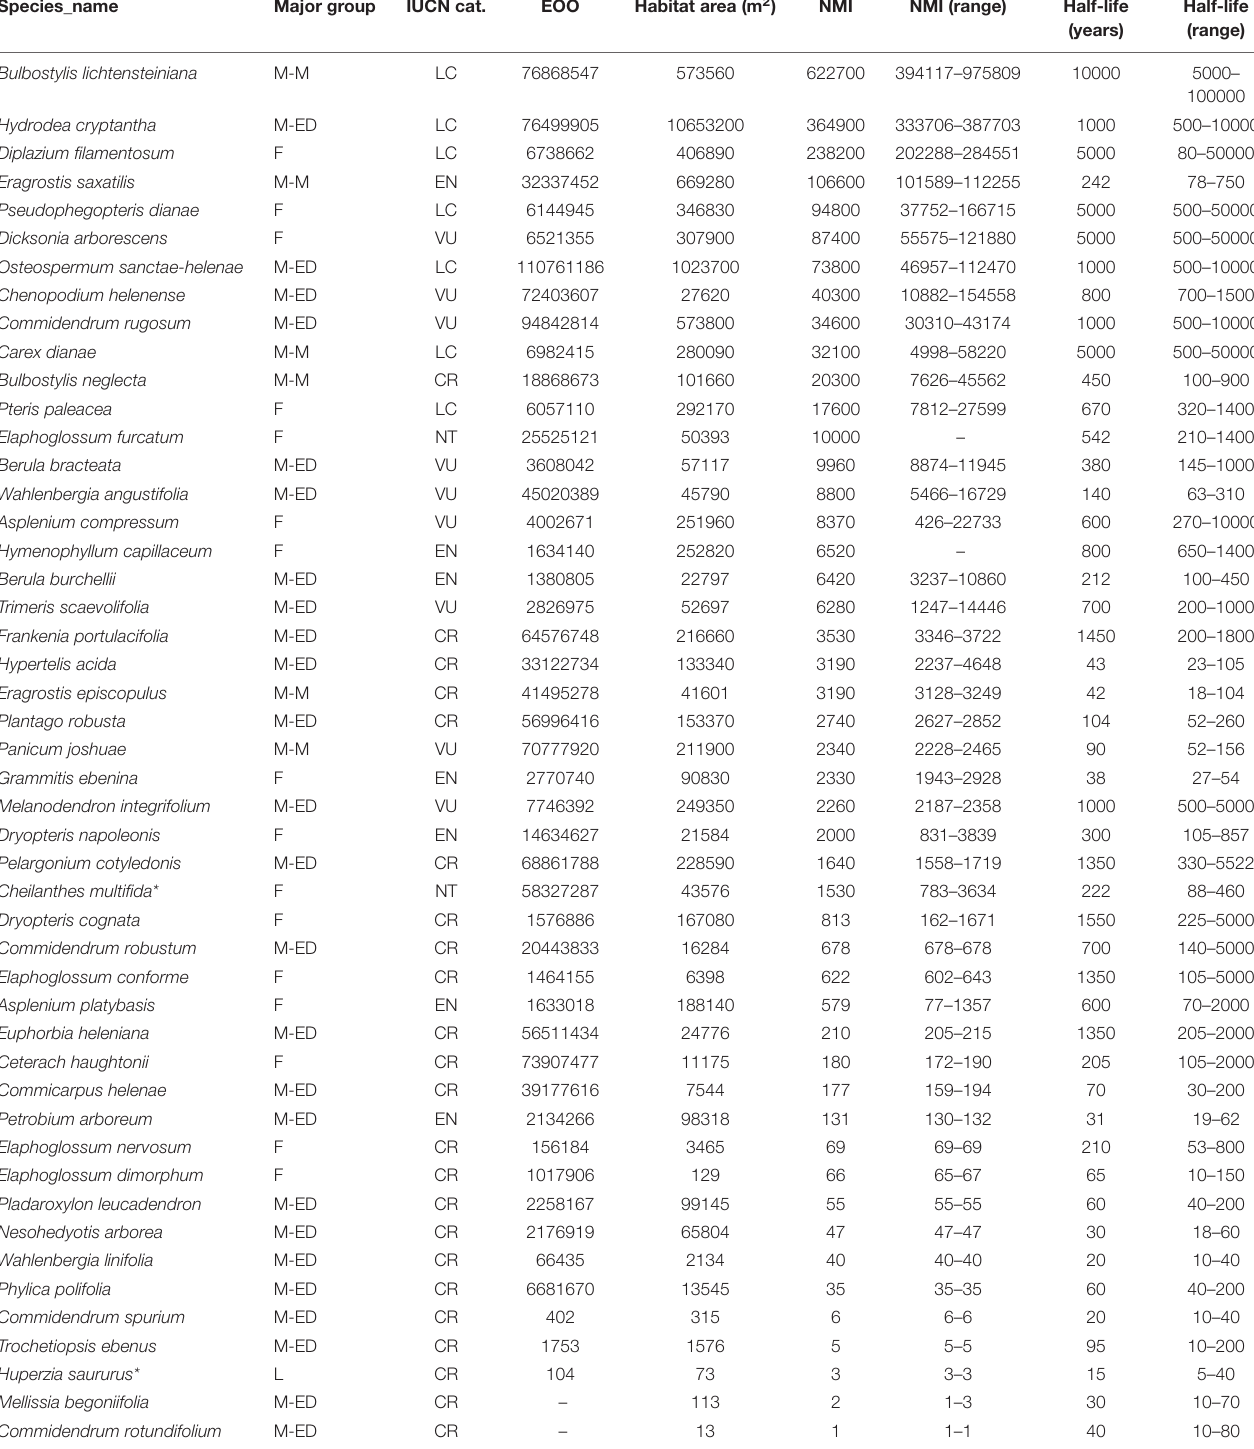
TABLE 2 | Endemic flora of St Helena extant in wild, with major phylogenetic groups indicated [M-M = Magnoliophyta (monocot); M-ED = Magnoliophyta (eudicot); L = Lycopodiophyta; F = Polypodiophyta